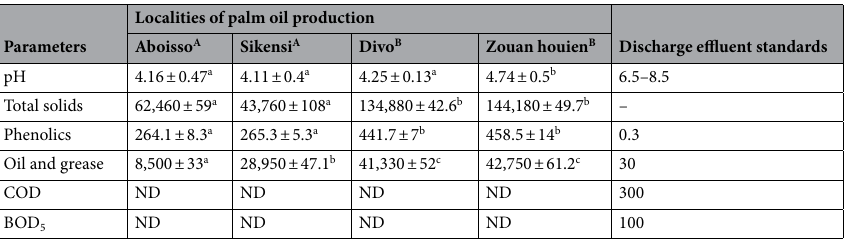
Table 1. Characteristics of palm oil mill effluents (POME) from four localities in Côte d’Ivoire. All parameters are in mg/L except pH. Averages with the same letter on same line only for chemical characteristics are not significantly different by ANOVA (α = 0.05). ND not determined. A Industrial POME. B Traditional POME. Each value is expressed as mean ± SEM (n = 3).